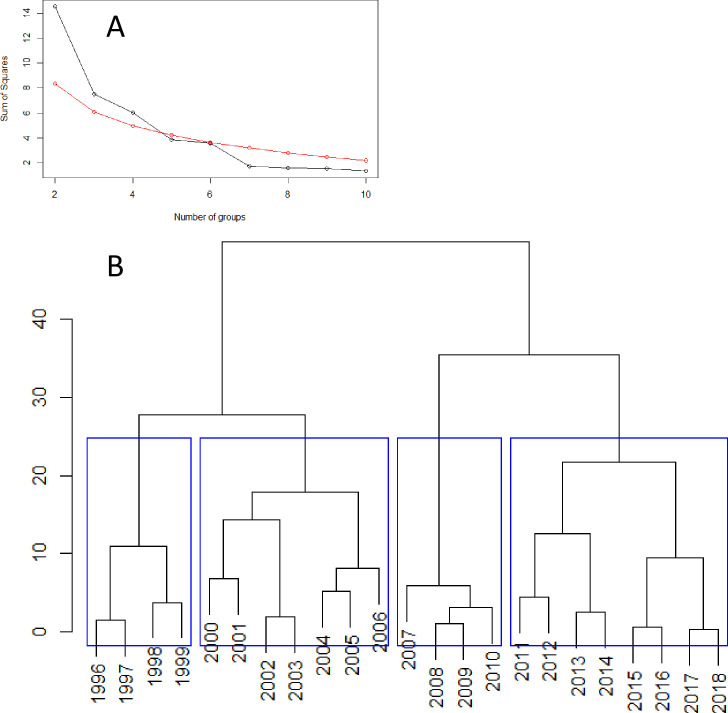
Constrained (chronological) clustering based on the two zooplankton and the two physical latent trends.A) Broken stick model to derive the number of significant clusters (black values on or above the red line are significant). B) Cluster dendrogram. Y-axis represents the Euclidean distance (magnitude of the difference) between successive comparisons of years. Blue boxes represent the four statistically-significant clusters.